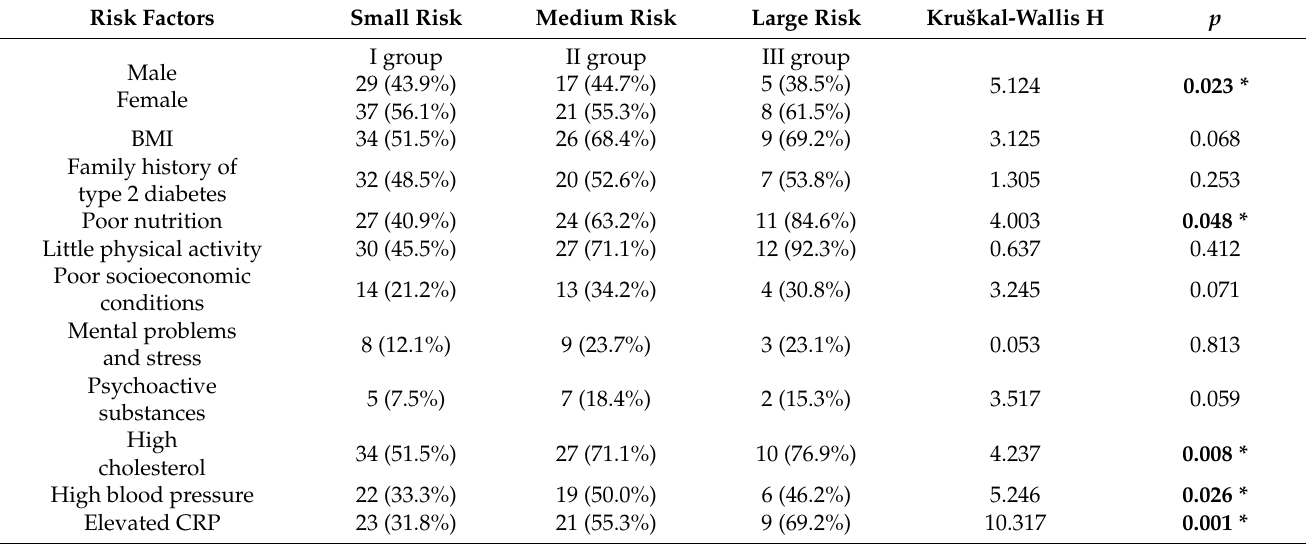
Table 3. Risk factors for